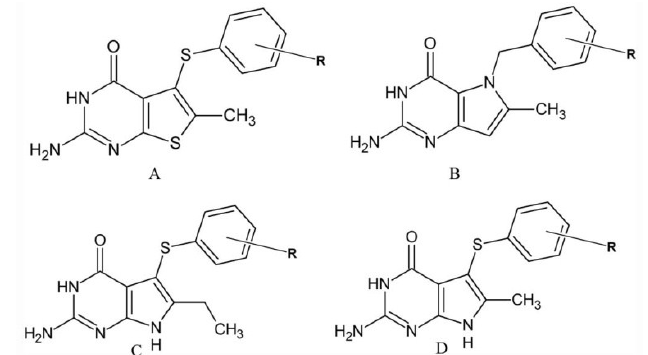
Figure 1. Core structures of pyrrolo pyrimidine and thieno pyrimidine